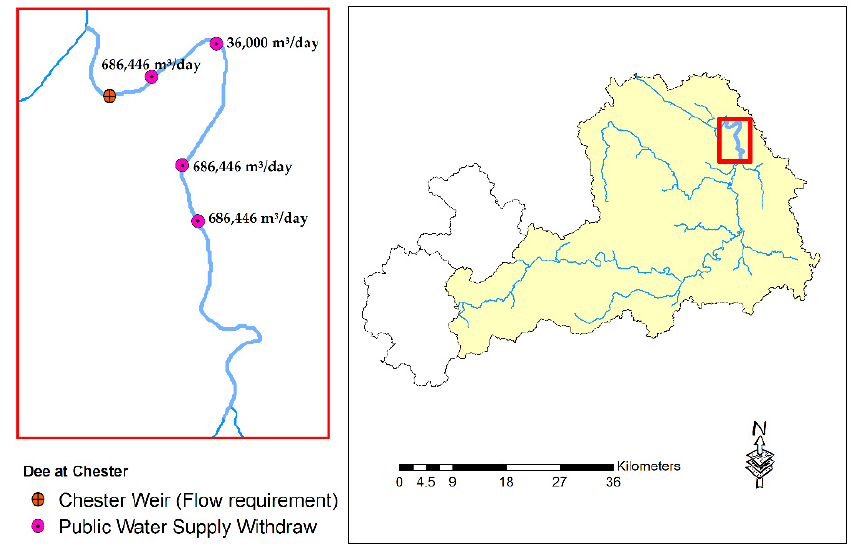
Figure 12. Study region of coupled SWAT-MODFLOW-WEAP model (surface-water abstraction, in m 3 /day).